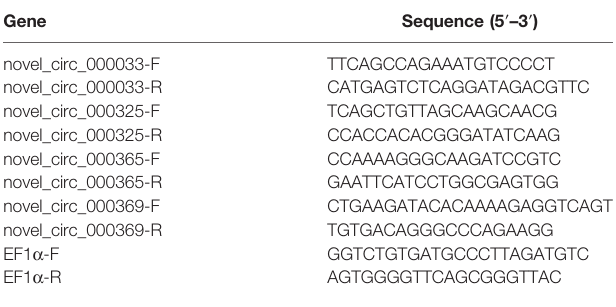
TABLE 1 | Information of qRT-PCR